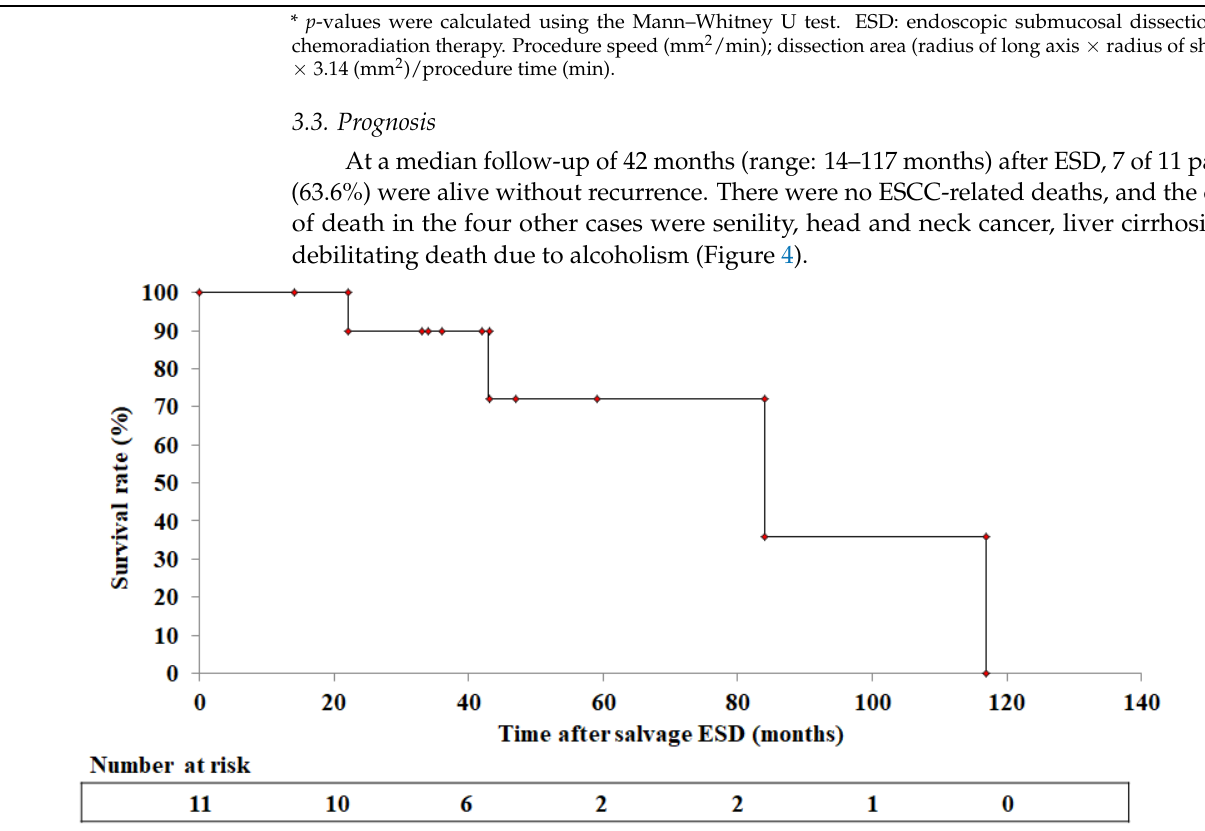
Figure 4. Overall survival of all 11 patients from the initiation of endoscopic submucosal